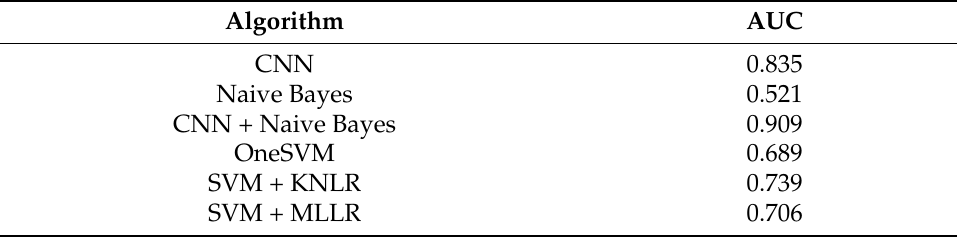
Figure 17. ROC comparison between different algorithms. Table 1. AUC values for performance